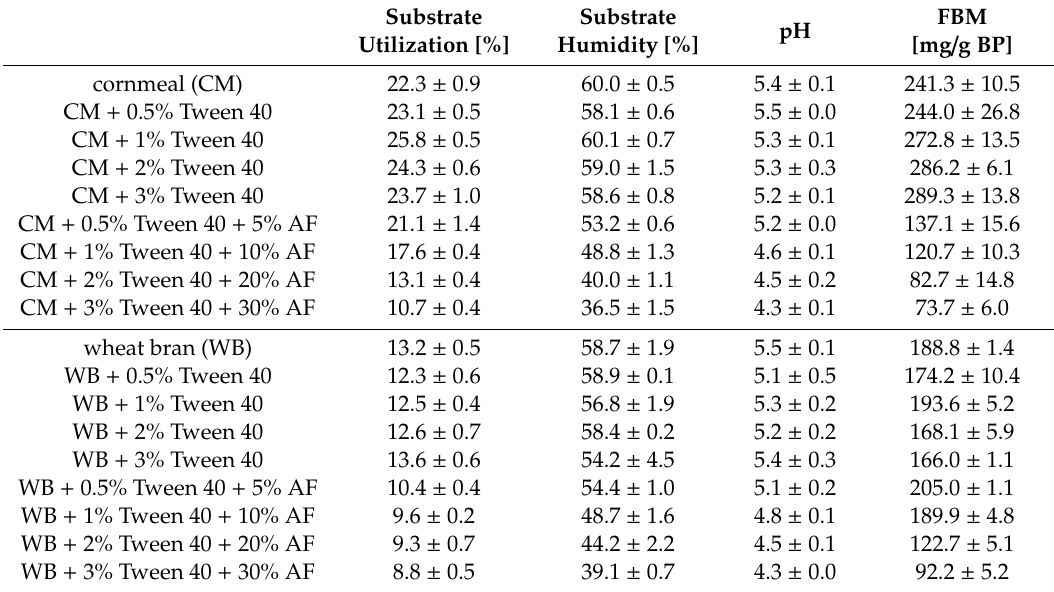
Table 3. Substrate utilization, substrate humidity, pH and fungal biomass (FBM) content in fermented bioproducts obtained from SSF of animal fat (AF) by ‐ product by Mortierella alpina .